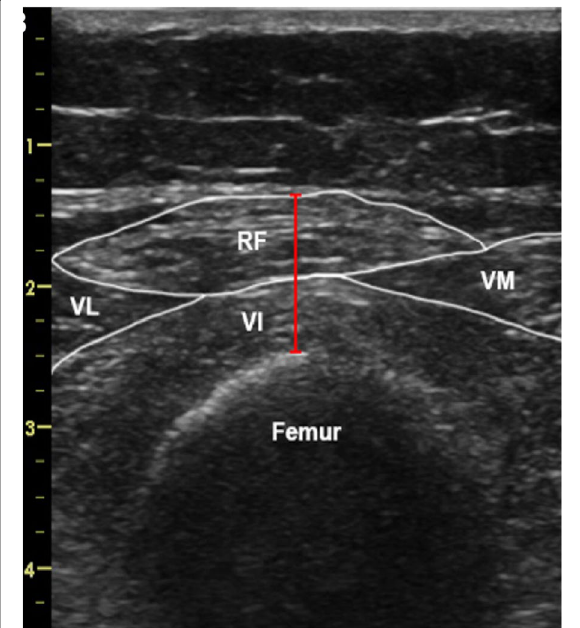
Fig. 3 Ultrasound assessment of the quadriceps femoris muscle thickness. Transverse ultrasound section made by linear probe at the midpoint site. RF: rectus femoris; VL: vastus lateralis; VM: vastus medialis; VI: vastus